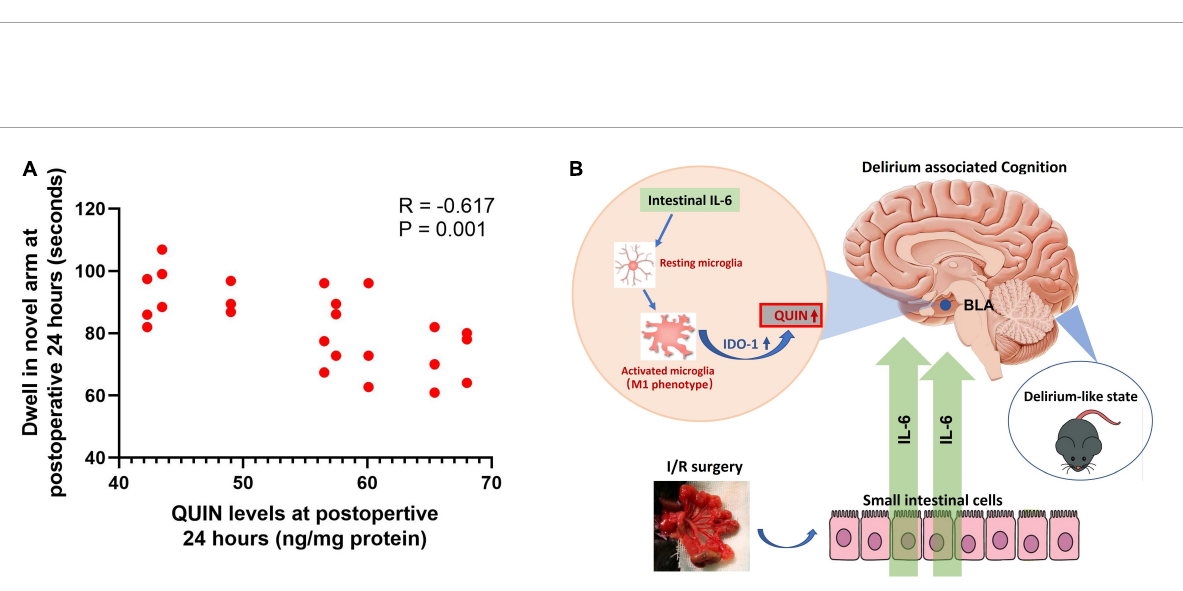
FIGURE6 Microglia reactivation and productions of IDO-1/QUIN in BLA triggered by extra peripheral IL-6 worsened the cognition in model mice. (A) Immunofluorescence staining and skeleton of microglia. (B) Analysis of microglia reactivation. (C) IDO-1 mRNA expression in BLA. (D) QUIN levels in BLA. (E) IL-6 levels in intestine, plasma and BLA. (F) Heating map of Y Maze Test. (G) Results of Y Maze Test. N = 10–12 per group for Y maze testing, N = 8 for others, * P < 0.05, ** P < 0.01. I/R, ischemia and reperfusion; BLA, basolateral amygdala; NS, normal saline; IL-6, Interleukin 6.